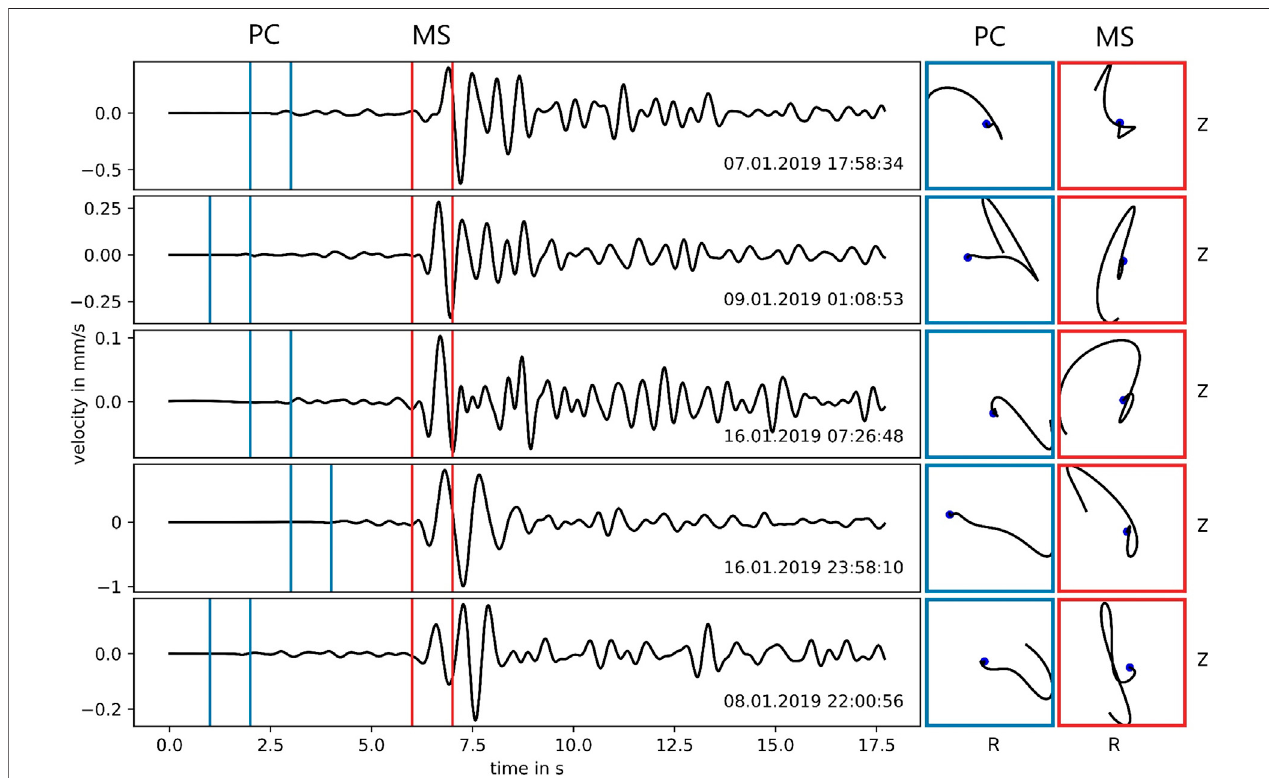
FIGURE6| SeismicgroundmotionatLIN3(Z-component,fourthorderButterworth fi lterf (cid:1) 0.125 – 3 Hz)andtheparticlemotionsintheRZ-plane.Theblueandred vertical lines mark the time windows used for the particle motion analysis and correspond to the polarization diagrams on the right. The blue window includes the PC onset and the red the onset of the MS. The blue dot indicates the start of the time